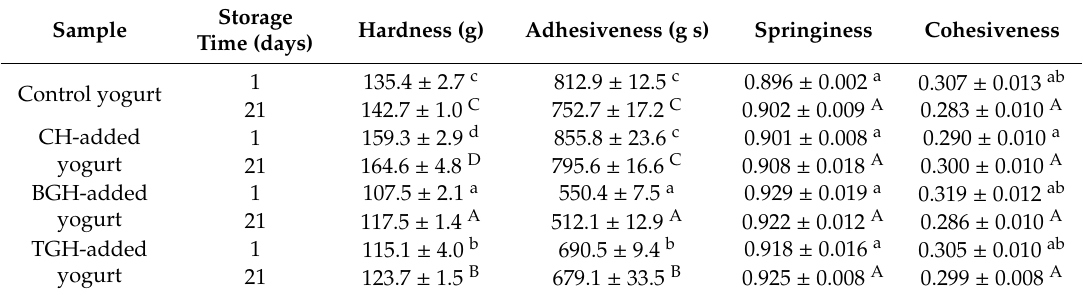
Table 2. Textural indices of the four yogurt samples stored at 4 ◦ C for 1 or 21 days.